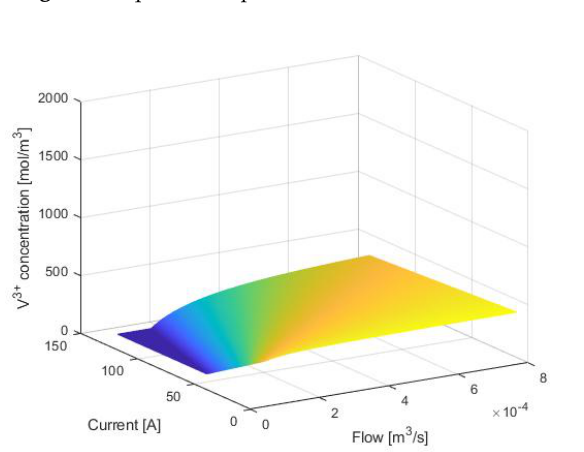
Figure 4. Equilibrium points of V 2 + for an 80% of SOC.